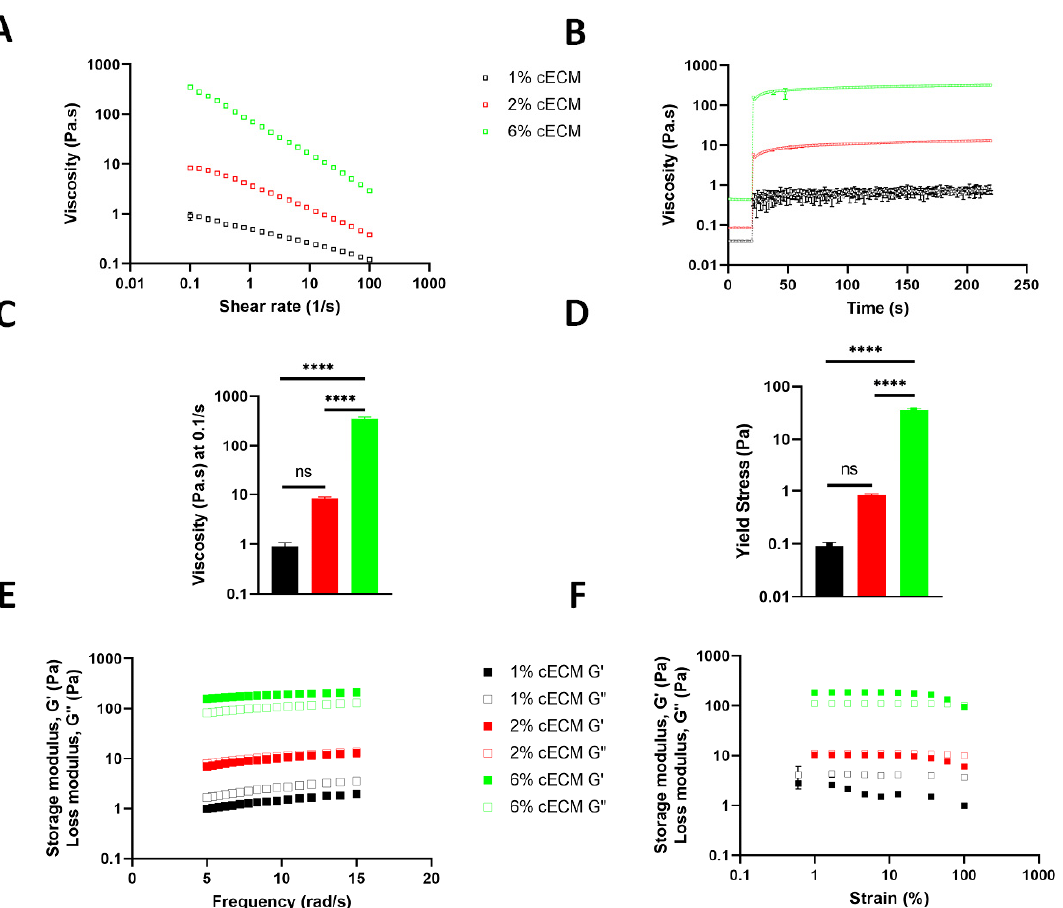
Figure 1. Rheological properties of formulations containing unmodified cartilage ECM ( n = 3). ( A ) Shear rate sweep from 0.1 to 100/s. ( B ) Shear recovery from 895/s (first 20 s) to 0.1/s (last 200 s). ( C ) Effect of cECM concentration on the viscosity at a shear rate of 0.1/s (close to zero shear) (ns = not significant; **** = p < 0.0001). ( D ) Effect of cECM concentration on the yield stress (flow initiation) (ns = not significant; **** = p < 0.0001). ( E ) Frequency sweeps of 1, 2, and 6% cECM. ( F ) Amplitude sweeps of 1, 2, and 6%